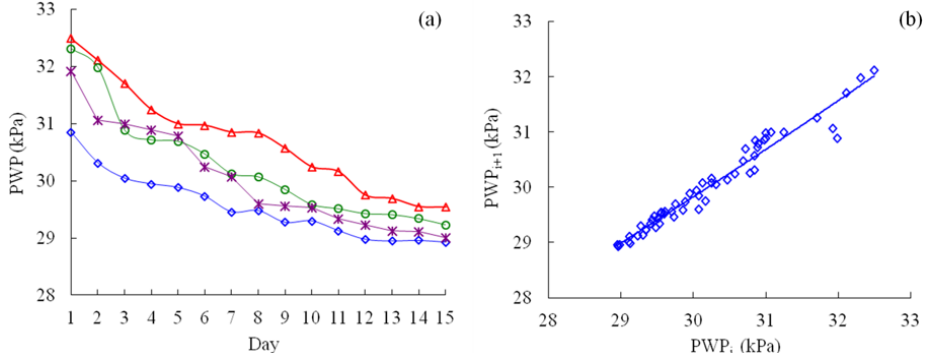
Figure 9. (a) Observation of PWP vs. time for four 15-day-long periods without rainfall or snowmelt (number of samples: n = 48). (b) PWP i vs. PWP i + 1 ( i th day of PWP correlates to i + 1th day of PWP for four 15-day-long periods without rainfall or snowmelt (number of samples: n =